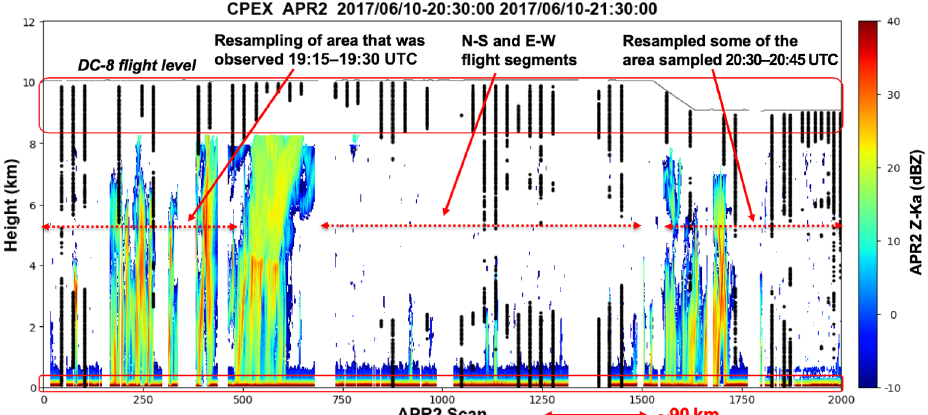
Figure 15. Cross section of the APR-2 Ka-band reflectivity (color scale to right) during segment 3 (20:30–21:30UTC). Same layout and format as Fig.